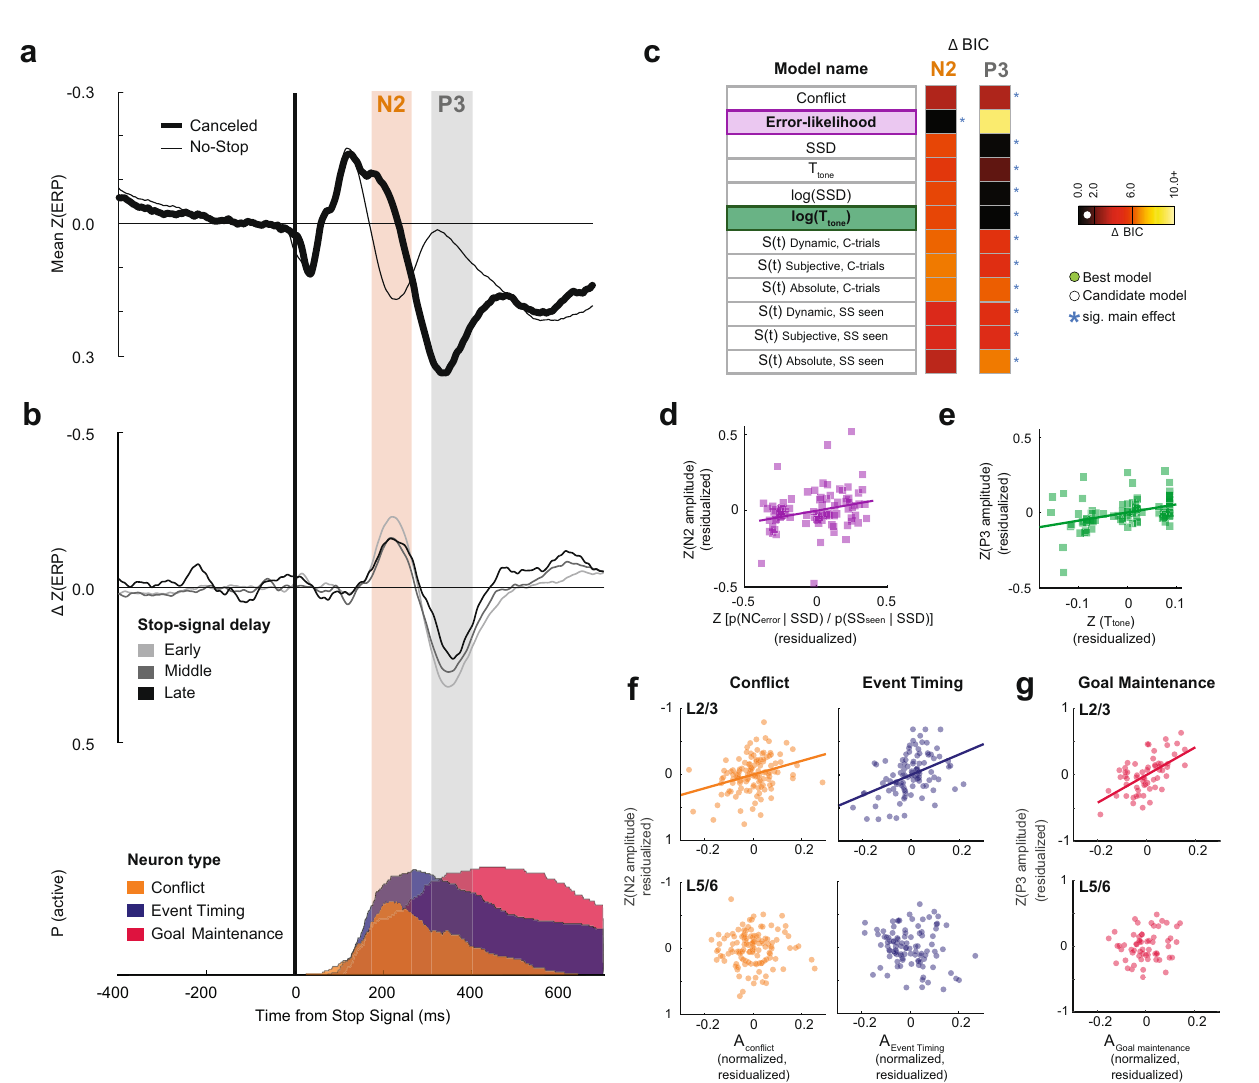
Fig. 5 | Goal maintenance neuron time – depth organization. Conventions as in Fig.3. a Averagespikerateandrecruitmentthroughtimeofneuronswithpersistent activityoncanceledrelativetolatency-matchedno-stop-signaltrials. b Time – depth plot. c Modulation on successfully canceled relative to latency-matched no-stop- signal trials for shorter and longer T tone of two representative neurons: n1 had narrow spikes in L3; n2 had broad spikes L3. Spiking of both neurons decreased after the tone. Shaded interval highlights signi fi cant differences in spiking across